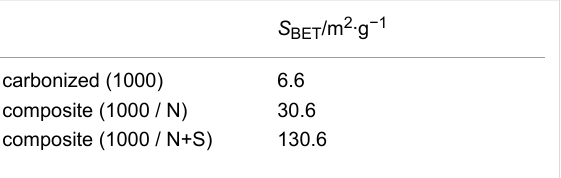
Table 1: BET surface areas of carbonized felt and composite elec- trodes heated up to 1000